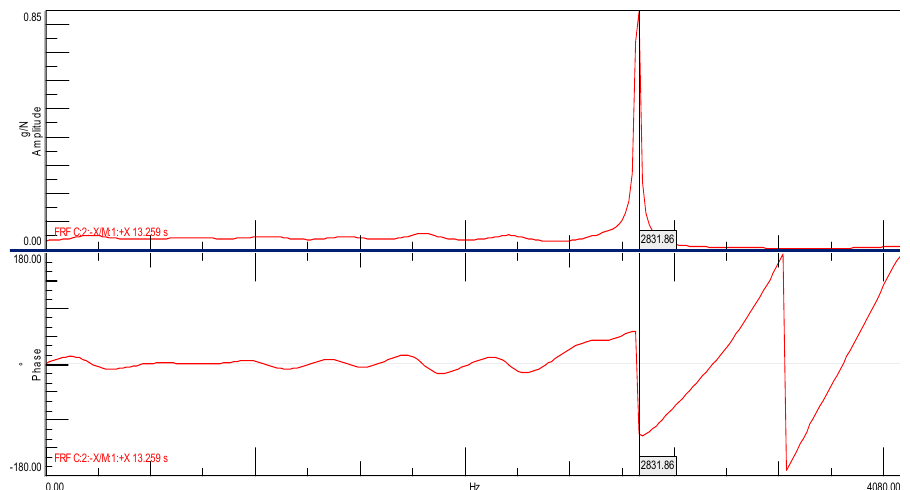
2831.86FRF C:2:-X/M:1:+X 13.259 s 0.00 Figure 16. Spectral function of the FRF transition for the ordinary concrete cube with the first natural frequency marked.